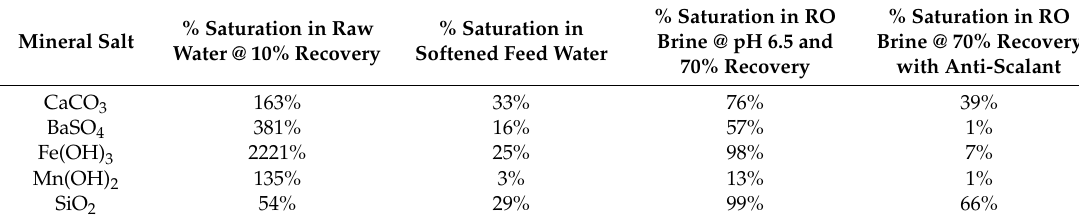
Table 6. Supersaturated mineral salts and their saturation levels in the influent. RO: reverse osmosis.